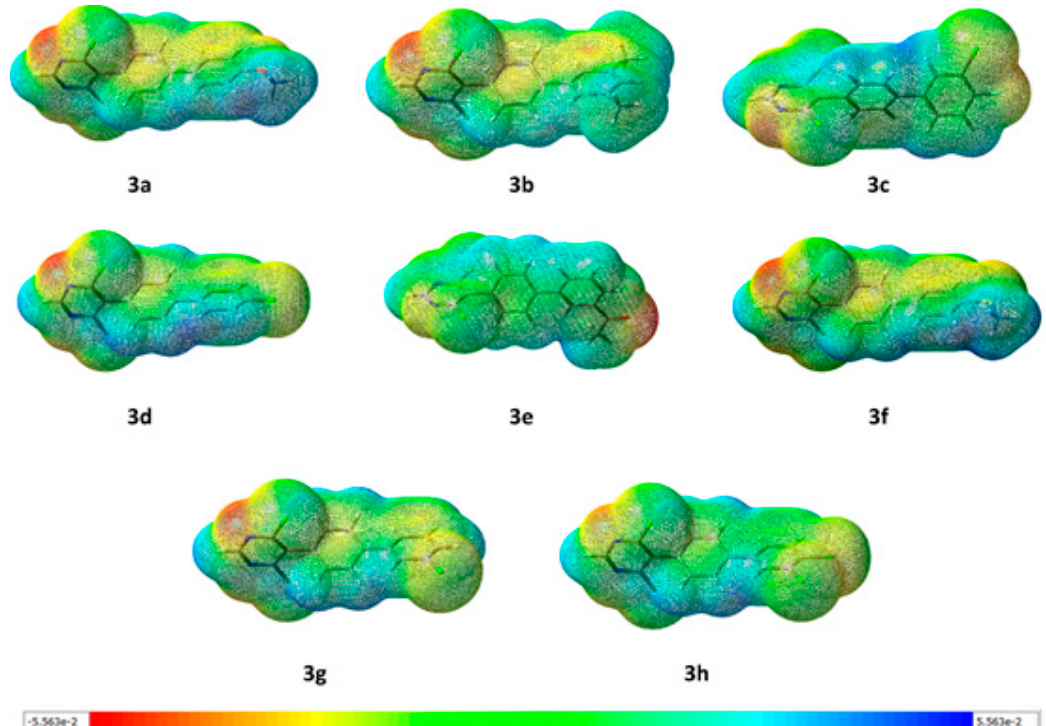
Figure 4. The presentation of molecular electrostatic potentials of the molecules ( 3a–3h ) calculated at the PBE0-D3BJ / def2-TZVP / SMD water level of theory. The below scale represents the color coding. The values in the scale are in Hartrees.